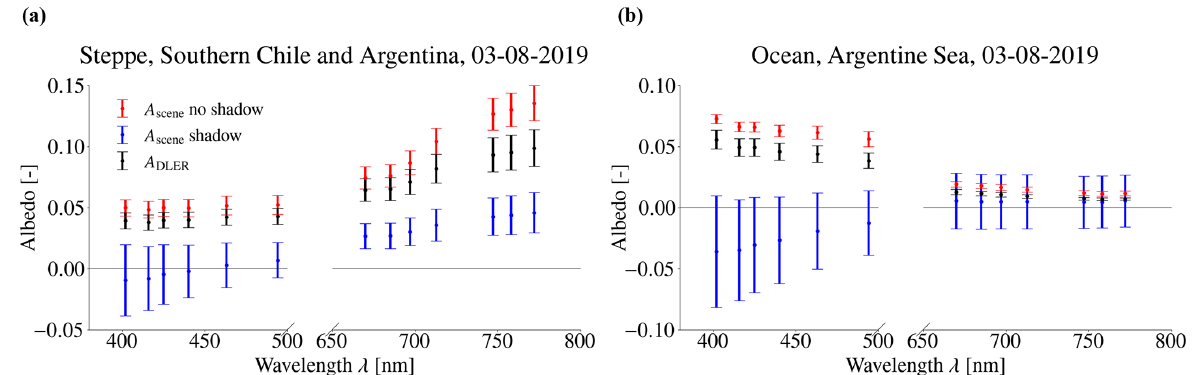
Figure 5. Spectra of the mean and 1 σ of the Lambertian-equivalent scene reflectivity (SCNLER) measured by TROPOMI at southern Chile and Argentina on 3 August 2019, for the steppe region within 52.5–50.5 ◦ S latitude and 71.5–70 ◦ W longitude (a) and for the ocean region within 53–51.5 ◦ S latitude and 67.5–66 ◦ W longitude (b) . Here, all measurements are cloud-free (i.e. without CF). The measurements affected by shadow (i.e. with ACSF) are presented in blue, and the shadow-free measurements (i.e. without PCSF) are presented in red. The additional black spectra are of the mean and 1 σ of the directionally dependent climatological Lambertian-equivalent reflectivity (DLER) at the TROPOMI ground pixels in the particular regions.